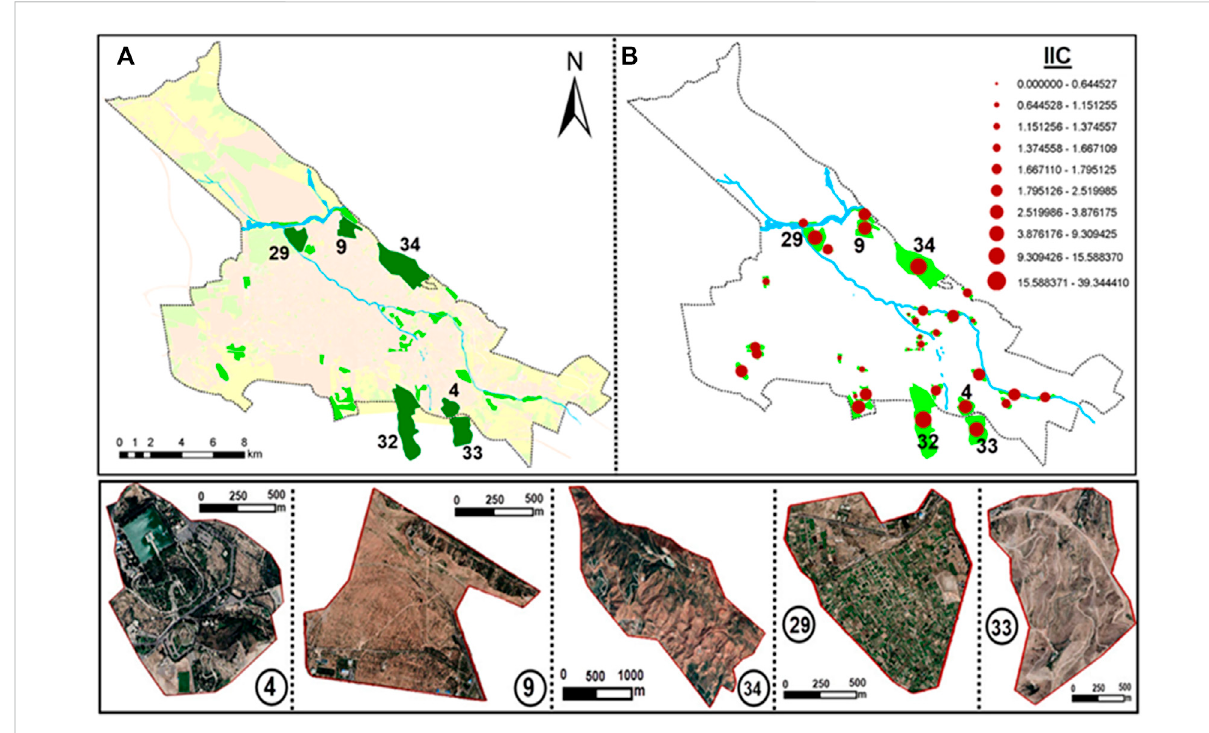
FIGURE 6 TheIICindexvaluesforthegreenspacesofTabrizcity (A) ,andthecoregreenpatchesofthecitybasedontheresultsofconnectivityindices (B)